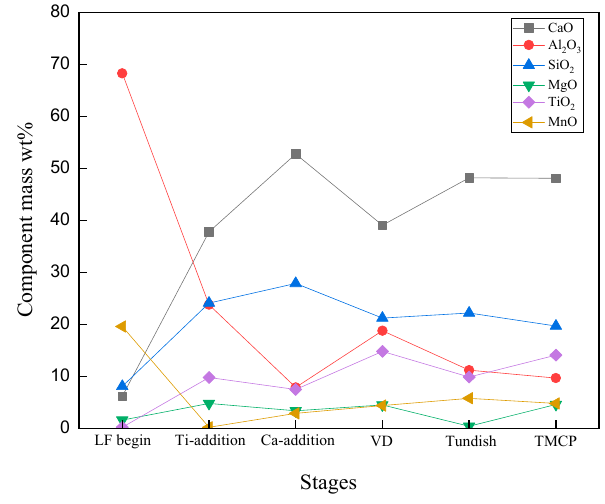
Figure 3. Oxide component in the inclusions at different stages.